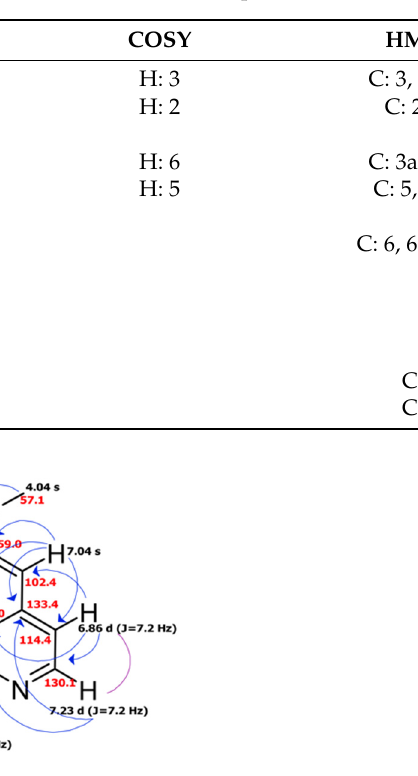
Table 1. NMR spectroscopic data ( 1 H 600 MHz, 13 C 150 MHz, MeOD- d 4 ) of aaptamine.